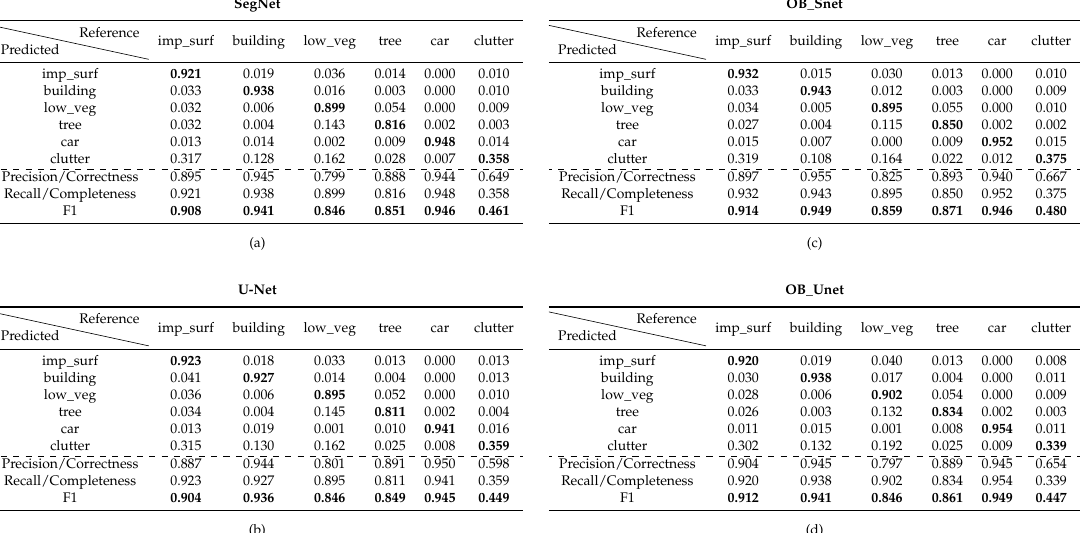
Figure 5. Resulting Confusion Matrices for the developed object-based learning frameworks (OB_Snet, OB_Unet and OB_FCN) on the Vaihingen dataset ( right ) and the corresponding ones for the state-of-the-art fully convolutional (SegNet, U-Net and FCN-16) networks ( left ). SegNet